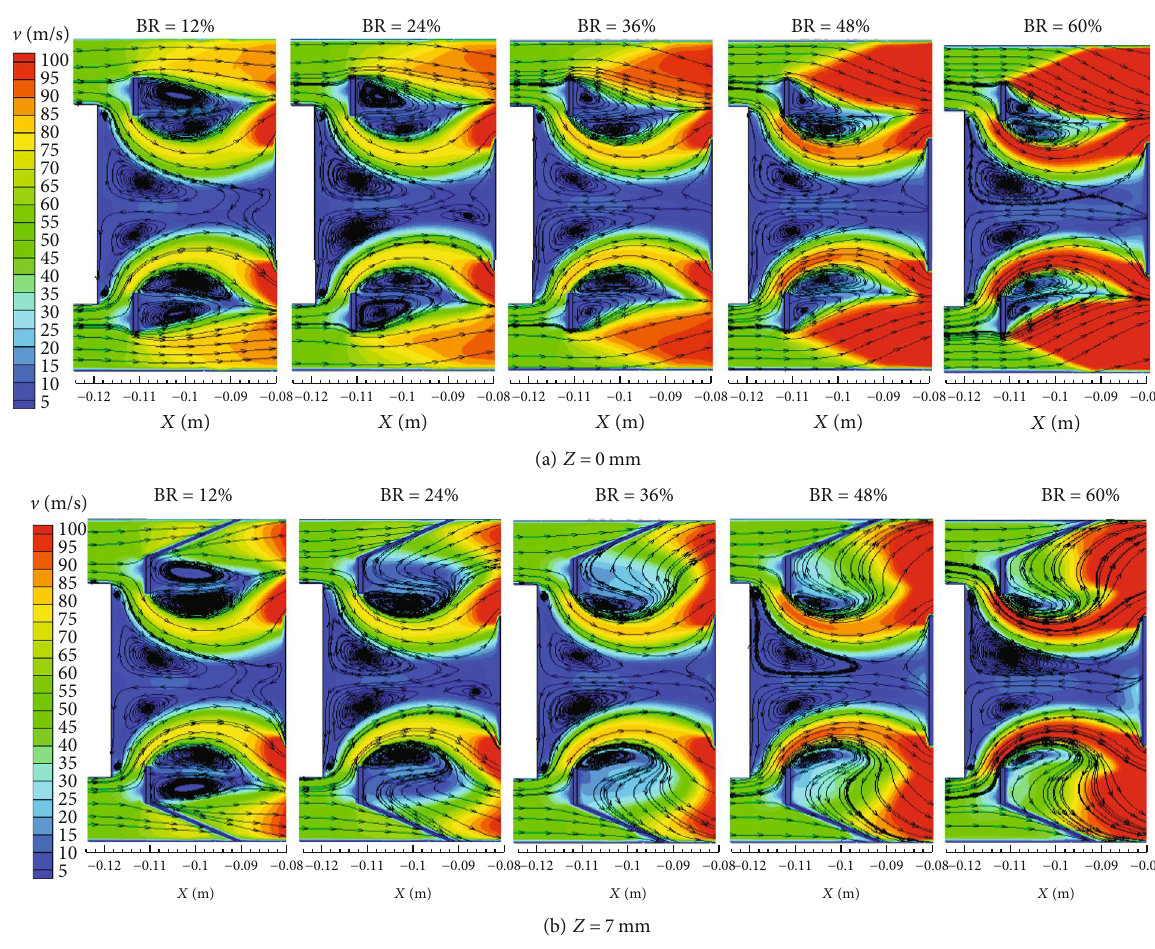
Figure 7: Velocity distribution under di ff erent BR.